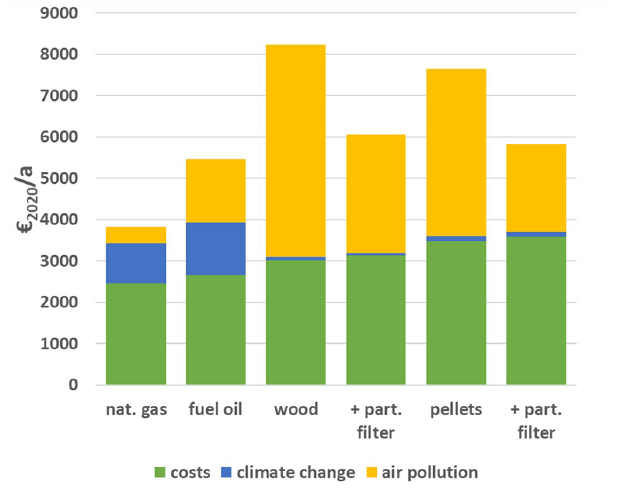
Figure 21. Social costs per year (annuity) of different heating boil- ers for an older single-family house in Stuttgart. Boilers are state- of-the-art technologies, and + part. filter means that wood or pel- let heating is additionally equipped with efficient particulate filters (Huang et al.,